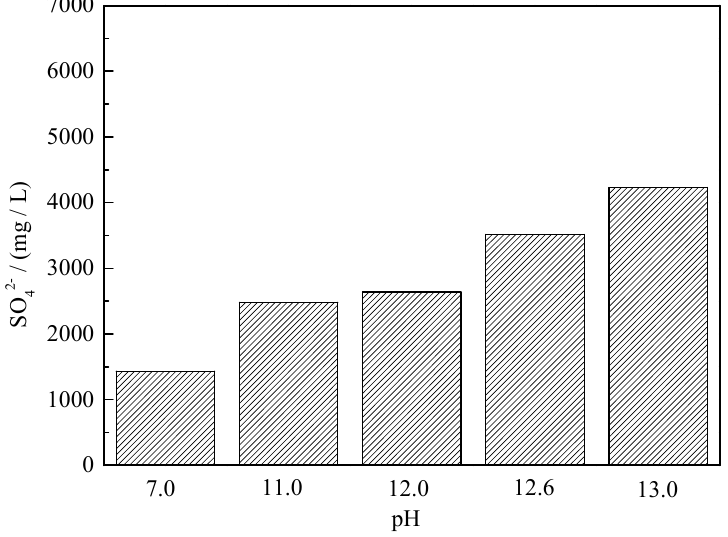
Figure 19. Concentration of SO 42 − in solutions at 360 d.